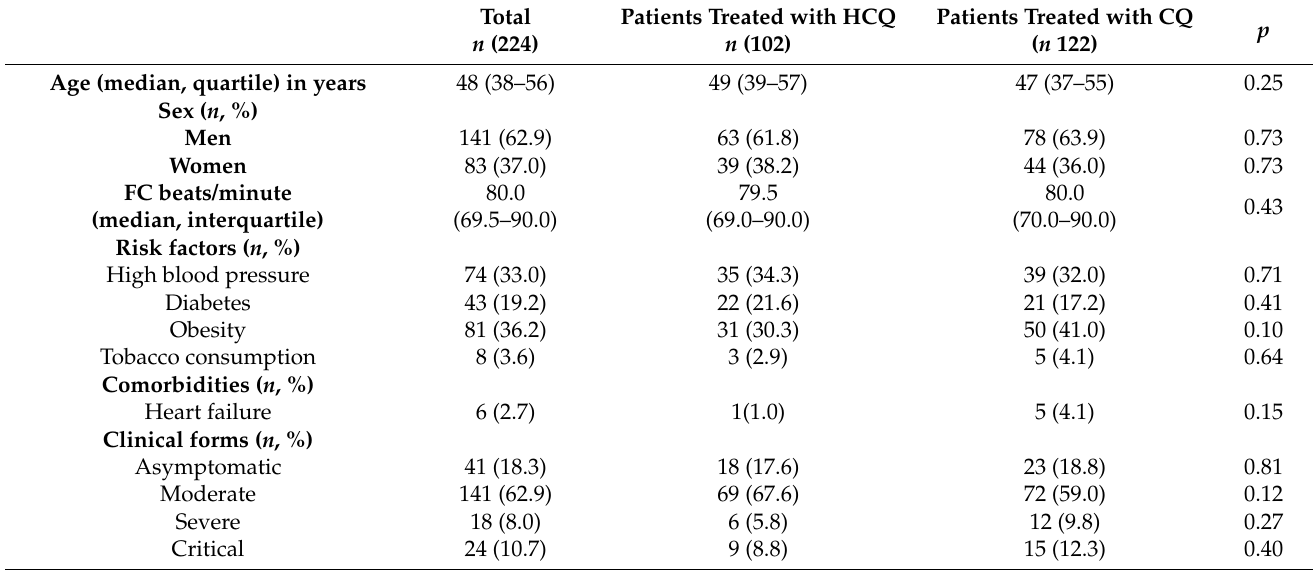
Table 1. Characteristics of COVID-19 patients at the